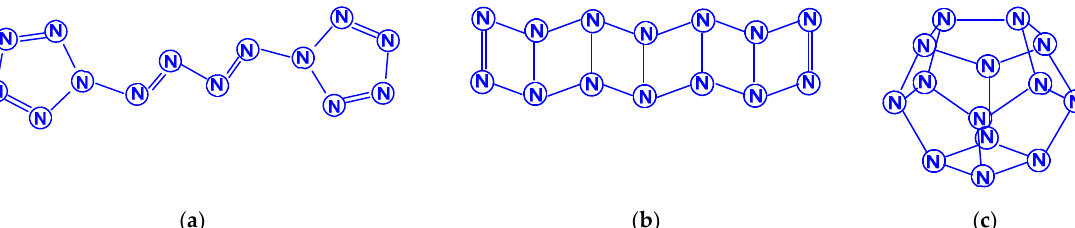
Scheme 13. ( a ): N 14 ( C 2h ); ( b ): N 14 ( C 2v ); ( c ): N 14 ( D 3h ).